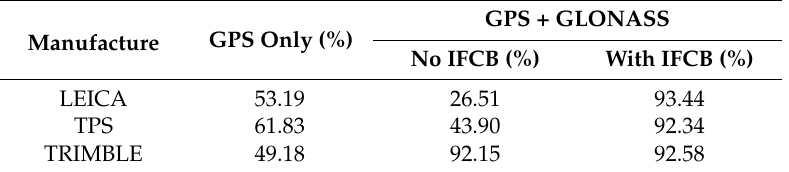
Figure 16. Fixing percentage for kinematic PPP with various strategies for observation duration 15 min for each station; rover stations are grouped according to the manufacturer. Table 5. Over-manufacturer-average fixing percentage with different strategies for observation duration 15 min.